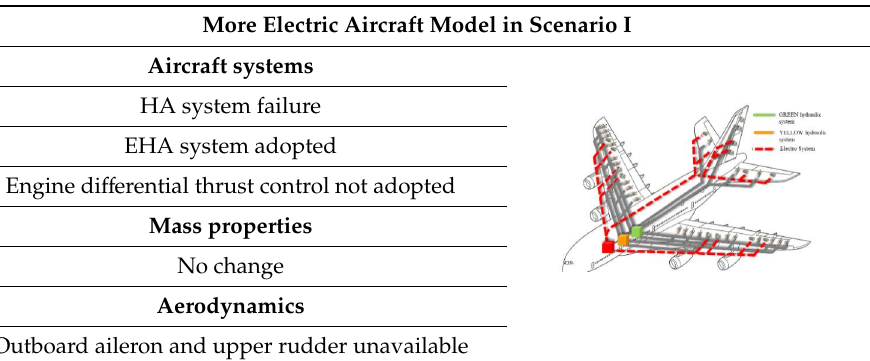
Table 1. Scenario I damage e ff ects towards the MEA aircraft.